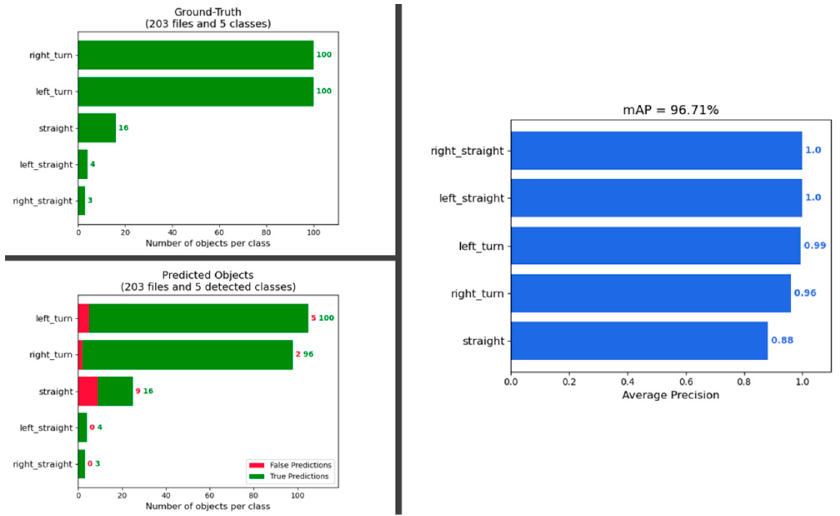
Figure 13. The quantitative evaluation information on the testing dataset of the improved model.